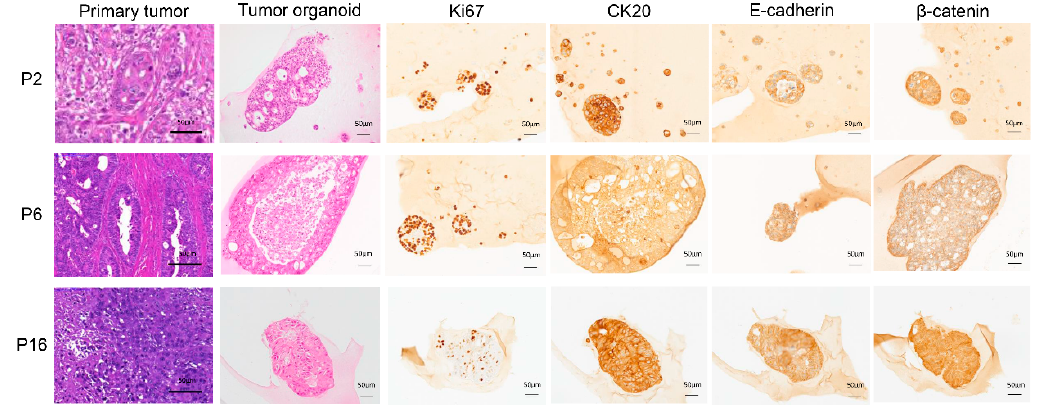
Figure 1. Organoid architecture resembles that of the primary tumor epithelium. Examples of H&E staining of tumor tissue and the paired tumor-derived organoid culture from three of the 22 organoid cultures. IHC staining for di ff erent tumor markers was performed on FFPE organoids, as established organoid cultures. IHC staining for different tumor markers was performed on FFPE indicated: Ki67, proliferation marker; CK20, pan di ff erentiation marker; E-cadherin, epithelial marker; organoids, as indicated: Ki67, proliferation marker; CK20, pan differentiation marker; E-cadherin, β -catenin, intracellular signal transducer in the WNT signaling pathway. Magnification: 20 × , scale bar: epithelial marker; β -catenin, intracellular signal transducer in the WNT signaling pathway. 50 µ Magnification: 20×, scale bar: 50 µm.